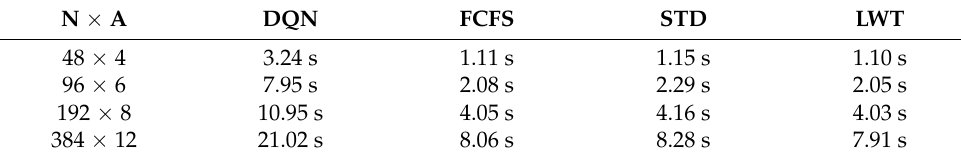
Table 8. Comparison of the computational